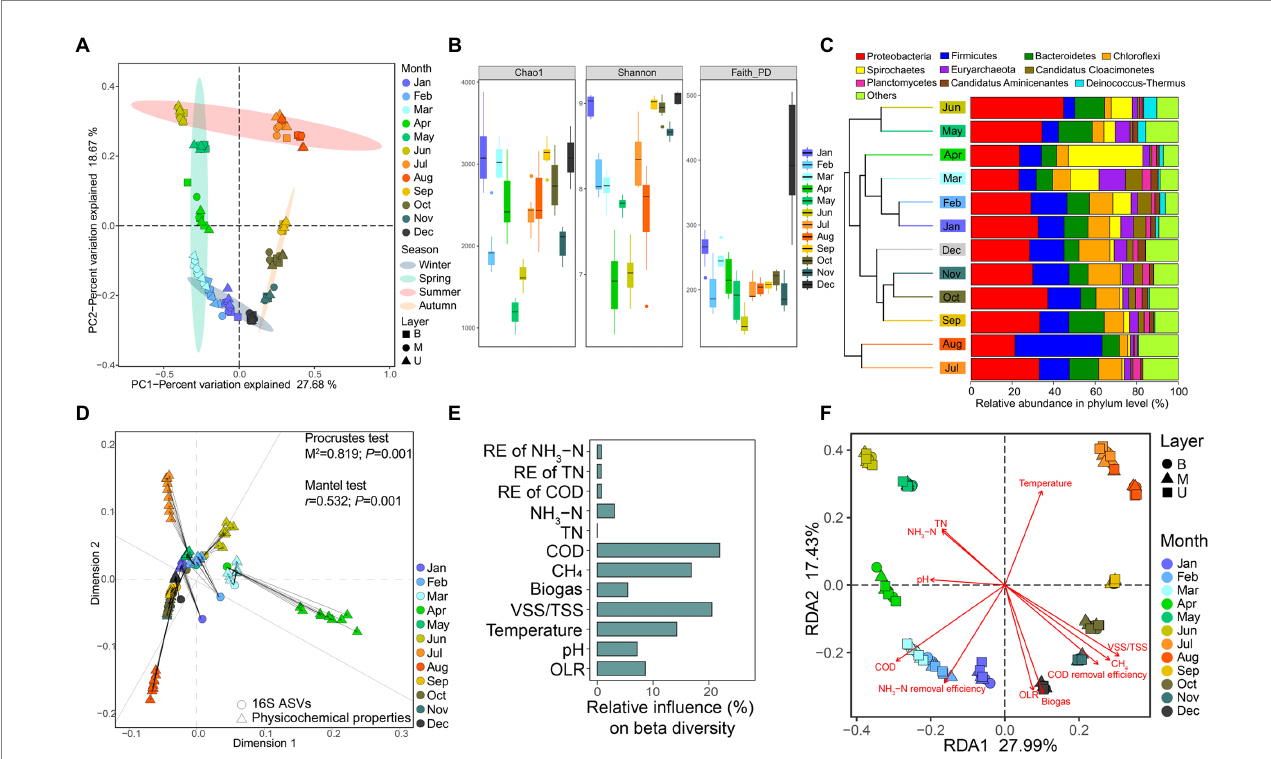
FIGURE 2 Overview of the composition, diversity, and variation of microbial communities with the changing physicochemical properties during the continuous operation of EGSB. (A) PCoA of bacterial communities in anaerobic activated sludge based on Bray–Curtis distances. Different color represents the sampling month and different symbol represents the sampling layer of the reactor. (B) Distribution of alpha indices (Chao1, Shannon, and Faith_PD) over 12 months. (C) Microbial community compositions at the phylum level across 12 months. Samples are collapsed and colored by month and clustered based on their Bray–Curtis distances. (D) Procrustes analysis of the changing physicochemical properties and the abundance of ASVs. Both the Procrustes test and the Mantel test are used for evaluating whether the association is significant and p < 0.05 is considered a significant correlation. (E) The relative contributions of different physicochemical properties to the group dissimilarities are determined by GBM analysis. (F) The ordination plot of redundancy analysis (RDA) for the microbial community. The relative variance explained by each axis was labeled in the axis title.